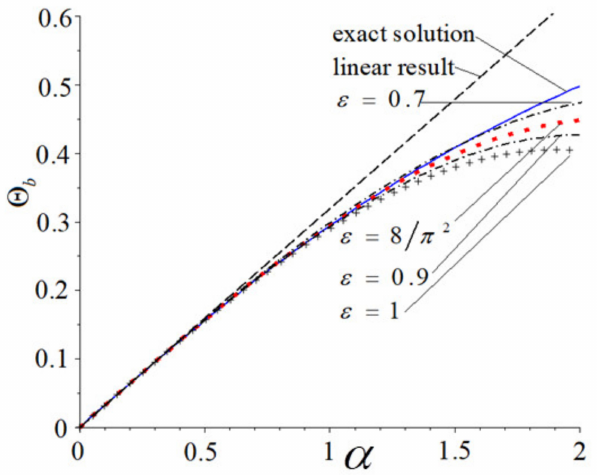
Figure 2. Rotation angle at free end vs. point force for different ε